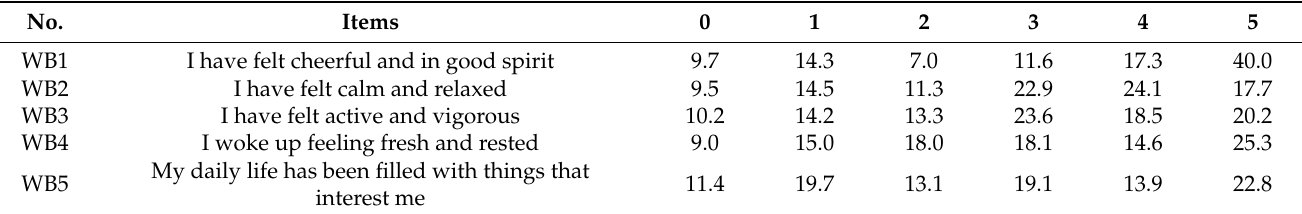
Table 1. Percentage of cases falling within each response category.